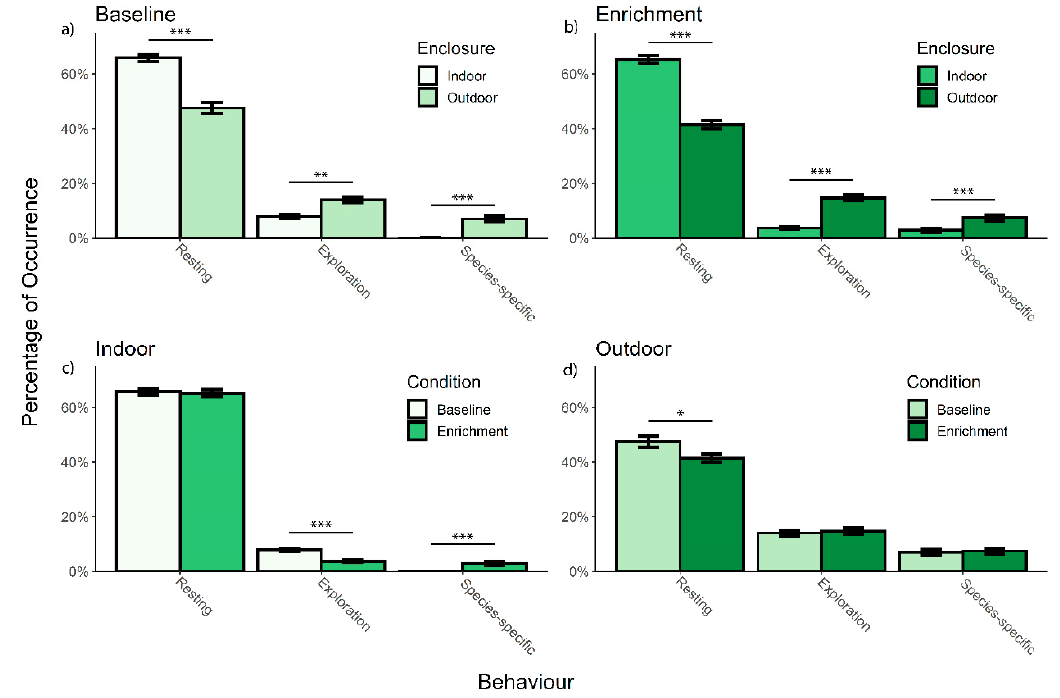
Figure 2. The percentage of occurrence ( ± SEM) for each behavioural category in the indoor and outdoor enclosure during the ( a ) baseline and during ( b ) enrichment condition; and during the baseline and enrichment condition in the ( c ) indoor enclosure and ( d ) outdoor enclosure. Comparisons were made using simple contrasts. * p < 0.05, ** p < 0.01, *** p < 0.001.